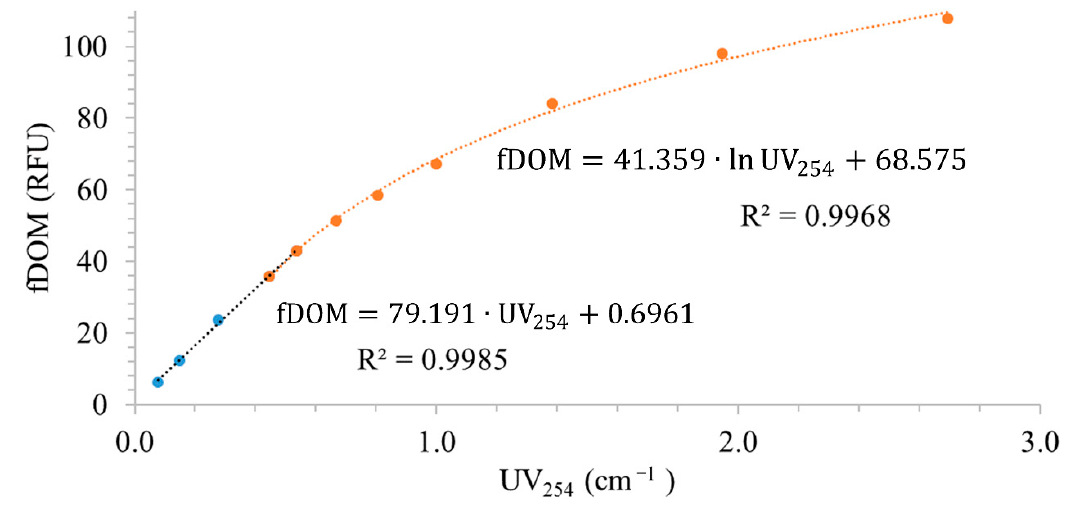
Figure 5. Effects of UV absorbance on fDOM readings, Capalaba.